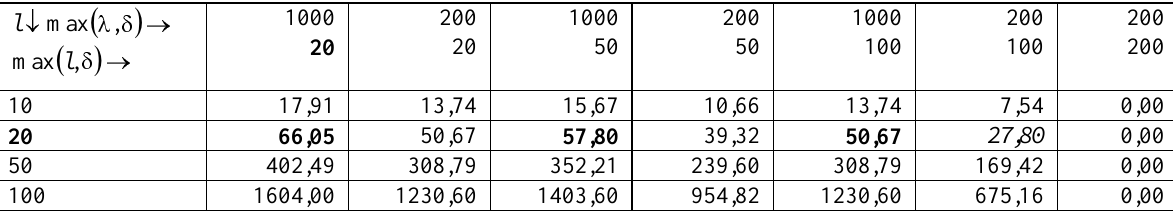
Table 3. Out-of-area gravimetric geoid standard deviation, Finnish gravimetric survey parameters: Units: mm